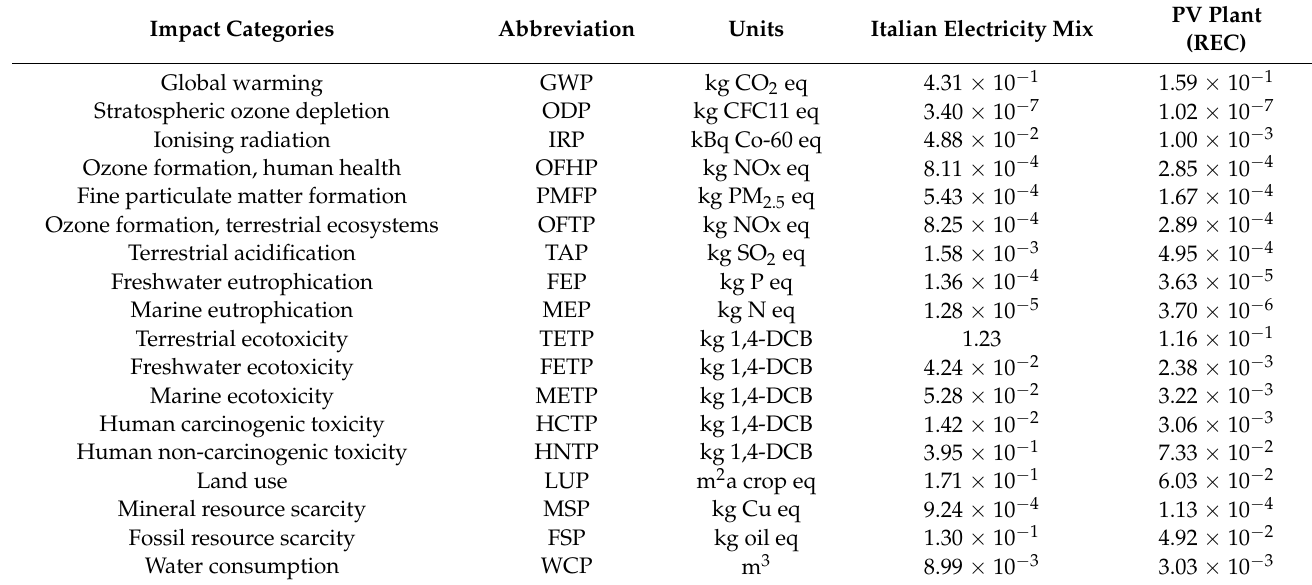
Table 4. Characterised impacts calculated for the evaluated PV plant compared to the Italian electricity mix—functional unit 1 kWh of electricity